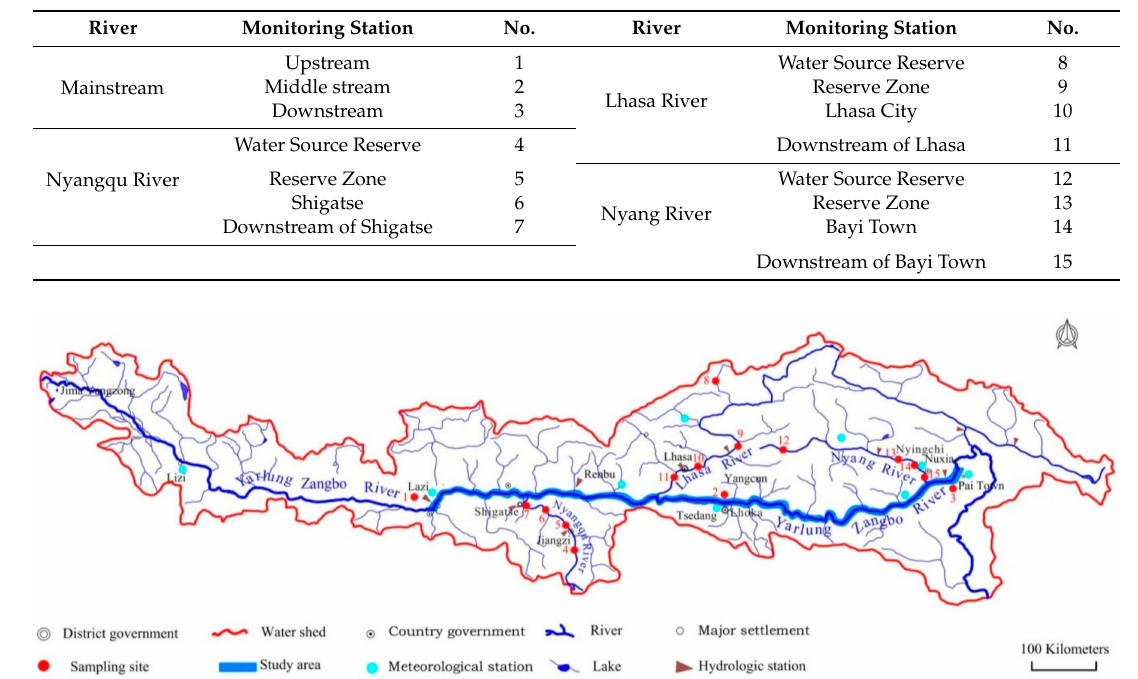
Table 2. Monitoring stations of P concentration.